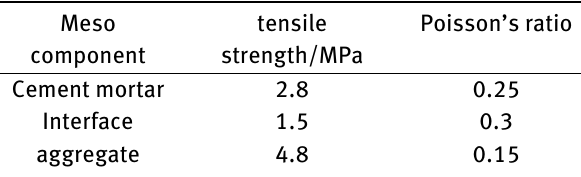
Table 1: Tensile strength and Poisson’s ratio of